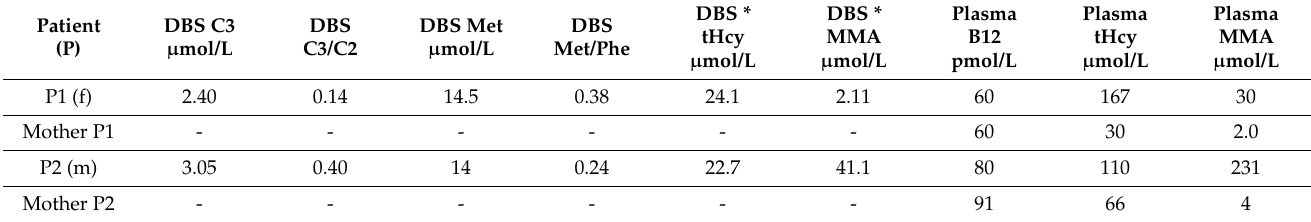
Table 3. B12 status and NBS results from two cases diagnosed with severe B12 deficiency at 8 and 9 months of age and their